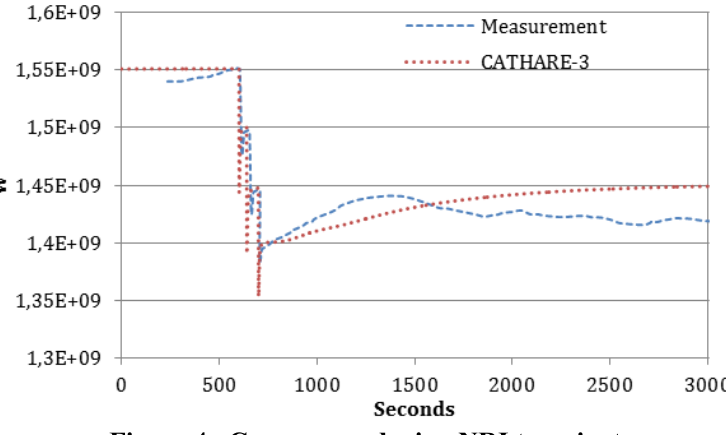
Figure 4. Core power during NRI transient